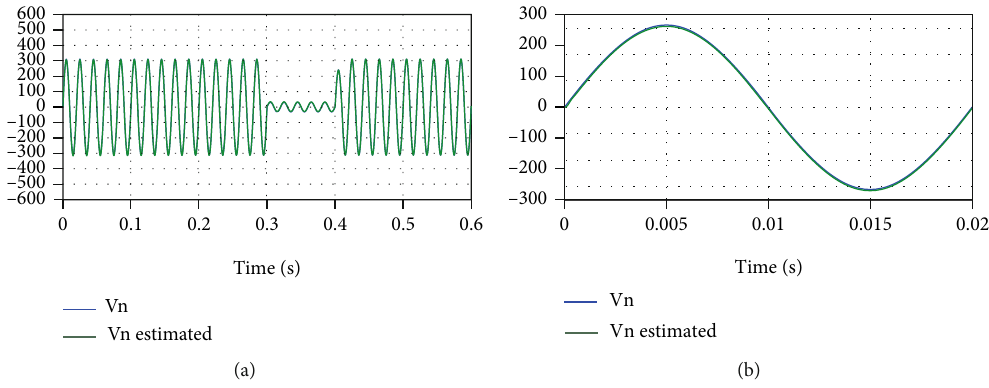
Figure 3: (a) Grid voltage x